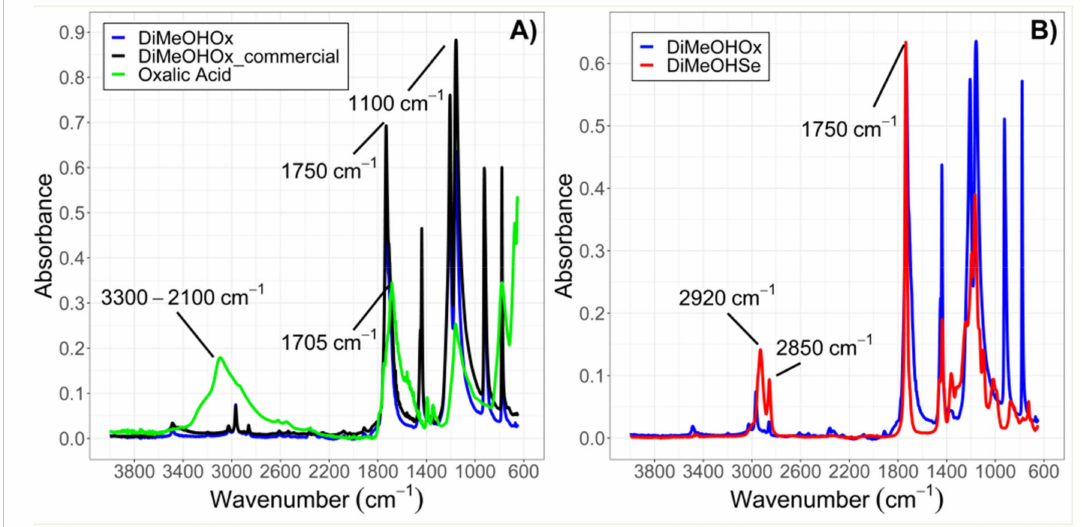
Figure 1. ( A ) Attenuated Total Reflectance (ATR)-IR spectra of commercial DiMeOHOx (black) and synthesized DiMeOHOx (blue) for comparison and synthesis validation. ( B ) Comparison between IR spectra of DiMeOHOx and DiMeOHSe. Due to the presence of longer carbon chains, DiMeOHSe presents enhanced peaks at 2820 cm − 1 and 2920 cm − 1